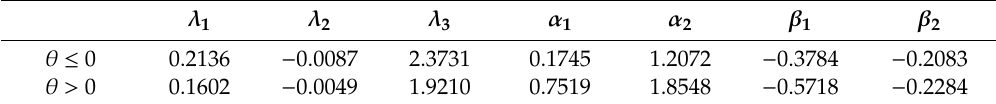
Figure 8. Energy dissipation characteristics: ( a ) Velocity ratio, ( b ) simulated against predicted velocity ratio, ( c ) relative energy loss and ( d ) simulated against predicted energy loss. Table 4. Coefficients in Equations (18), (20) and (21).